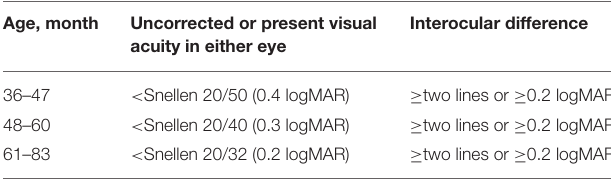
TABLE 1 | Age-specific criteria for referral in preschool vision screening.